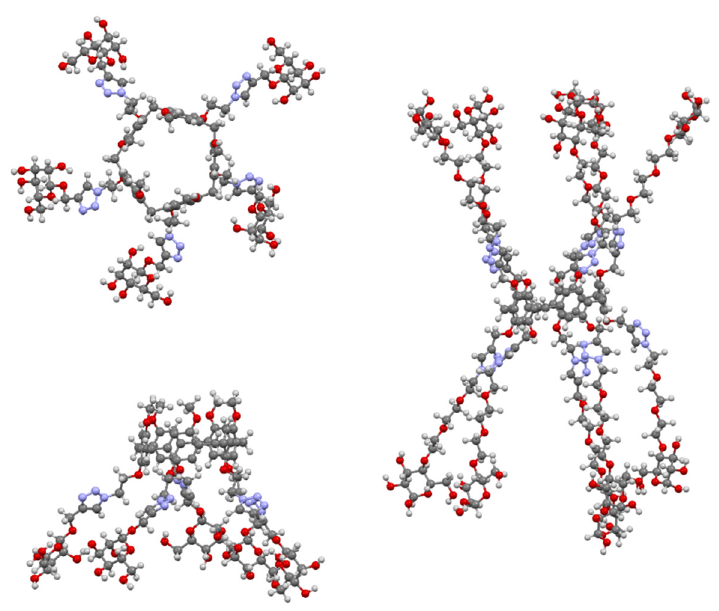
Figure 32. Glycosylated pillar[5]arenes 173 ( top and side ) and 176 ( side ) illustrating their multivalent binding potential.